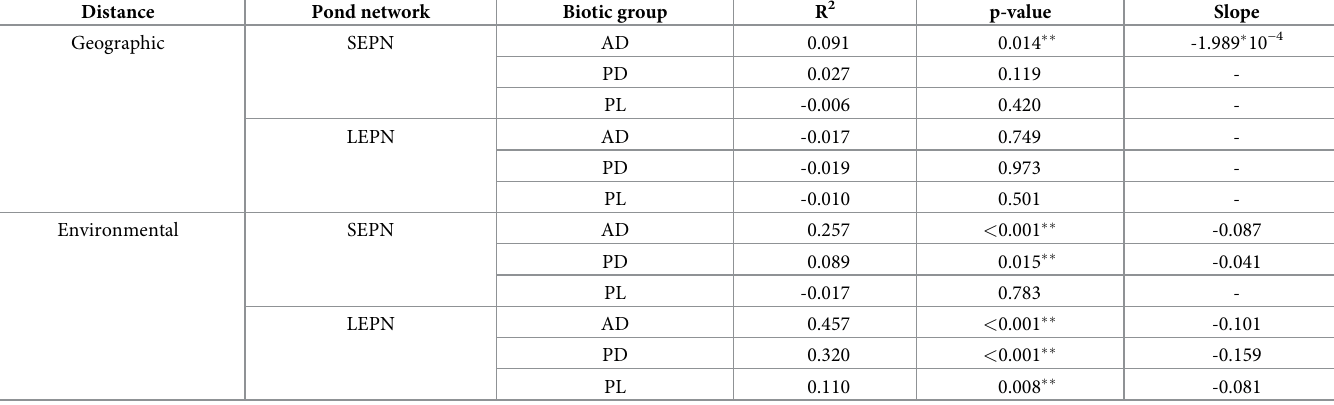
Table 3. Regression parameters for the relationship between community similarity and distance (geographic and environmental) for each biotic group in the SEPN and LEPN.